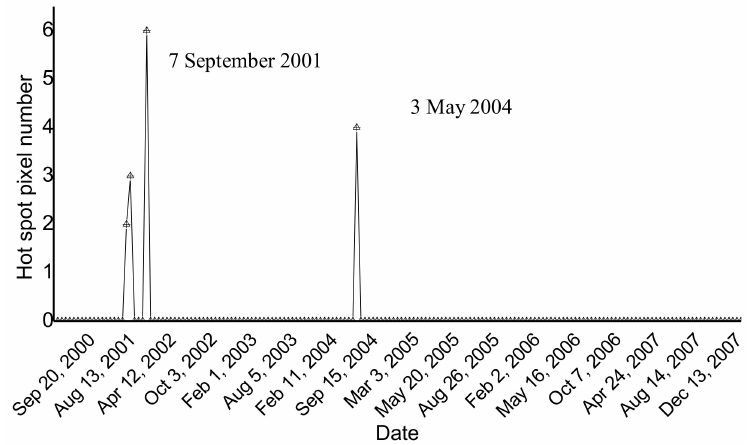
Figure 9. Hot pixels flagged by NHI at Shishaldin (Alaska, USA) volcano using infrared ASTER data of March 2000–2008.